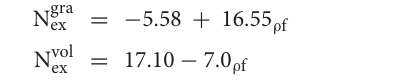
for the adsorbent and another for bulk adsorbate.